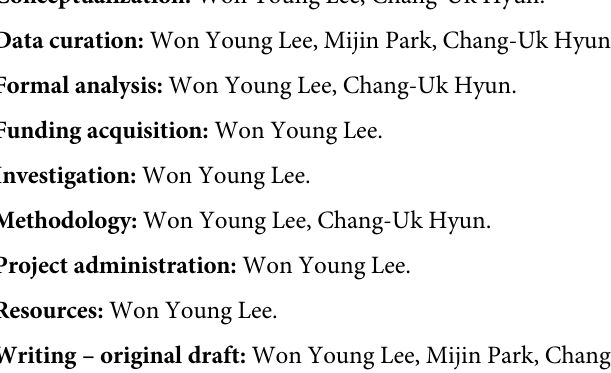
S1 Fig. Results of image mosaicking using 138 RGB images. (A) Image locations and mosa- icked images. Red dots indicate the exact locations of RGB image acquisition during the UAV flight. In the black square, white dots were detected. (B) A zoomed image around the white dots which were suspected to be birds. S2 Fig. Number of image overlaps of the RGB images acquired during the blind survey. S3 Fig. A thermal image overlaid on the mosaicked RGB image for a blind